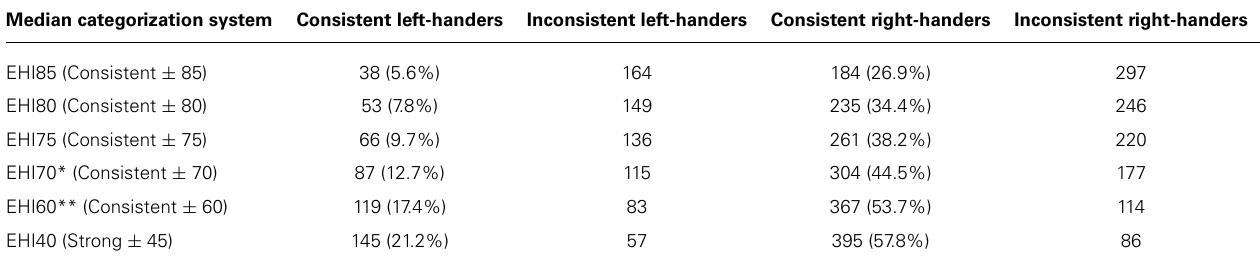
Table 2 | Influence of split value used, in terms of number of participants in each category. Median categorization system Consistent left-handers Inconsistent left-handers Consistent right-handers Inconsistent right-handers EHI85 (Consistent ±